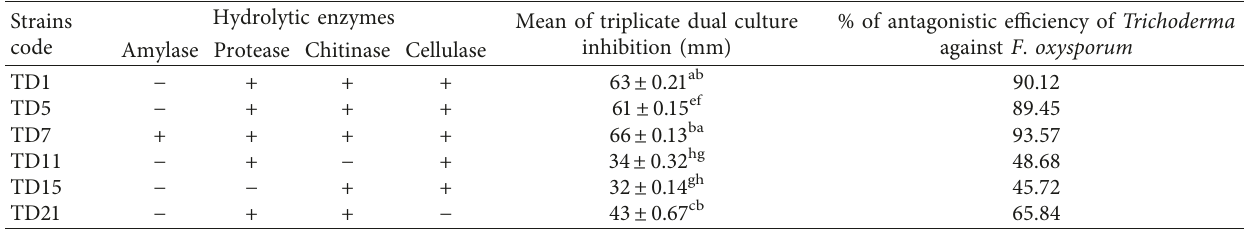
Table 3: Hyperparasitism mechanism of Trichoderma strains via hydrolytic enzymes and their in vitro antagonistic activity via antibiotic